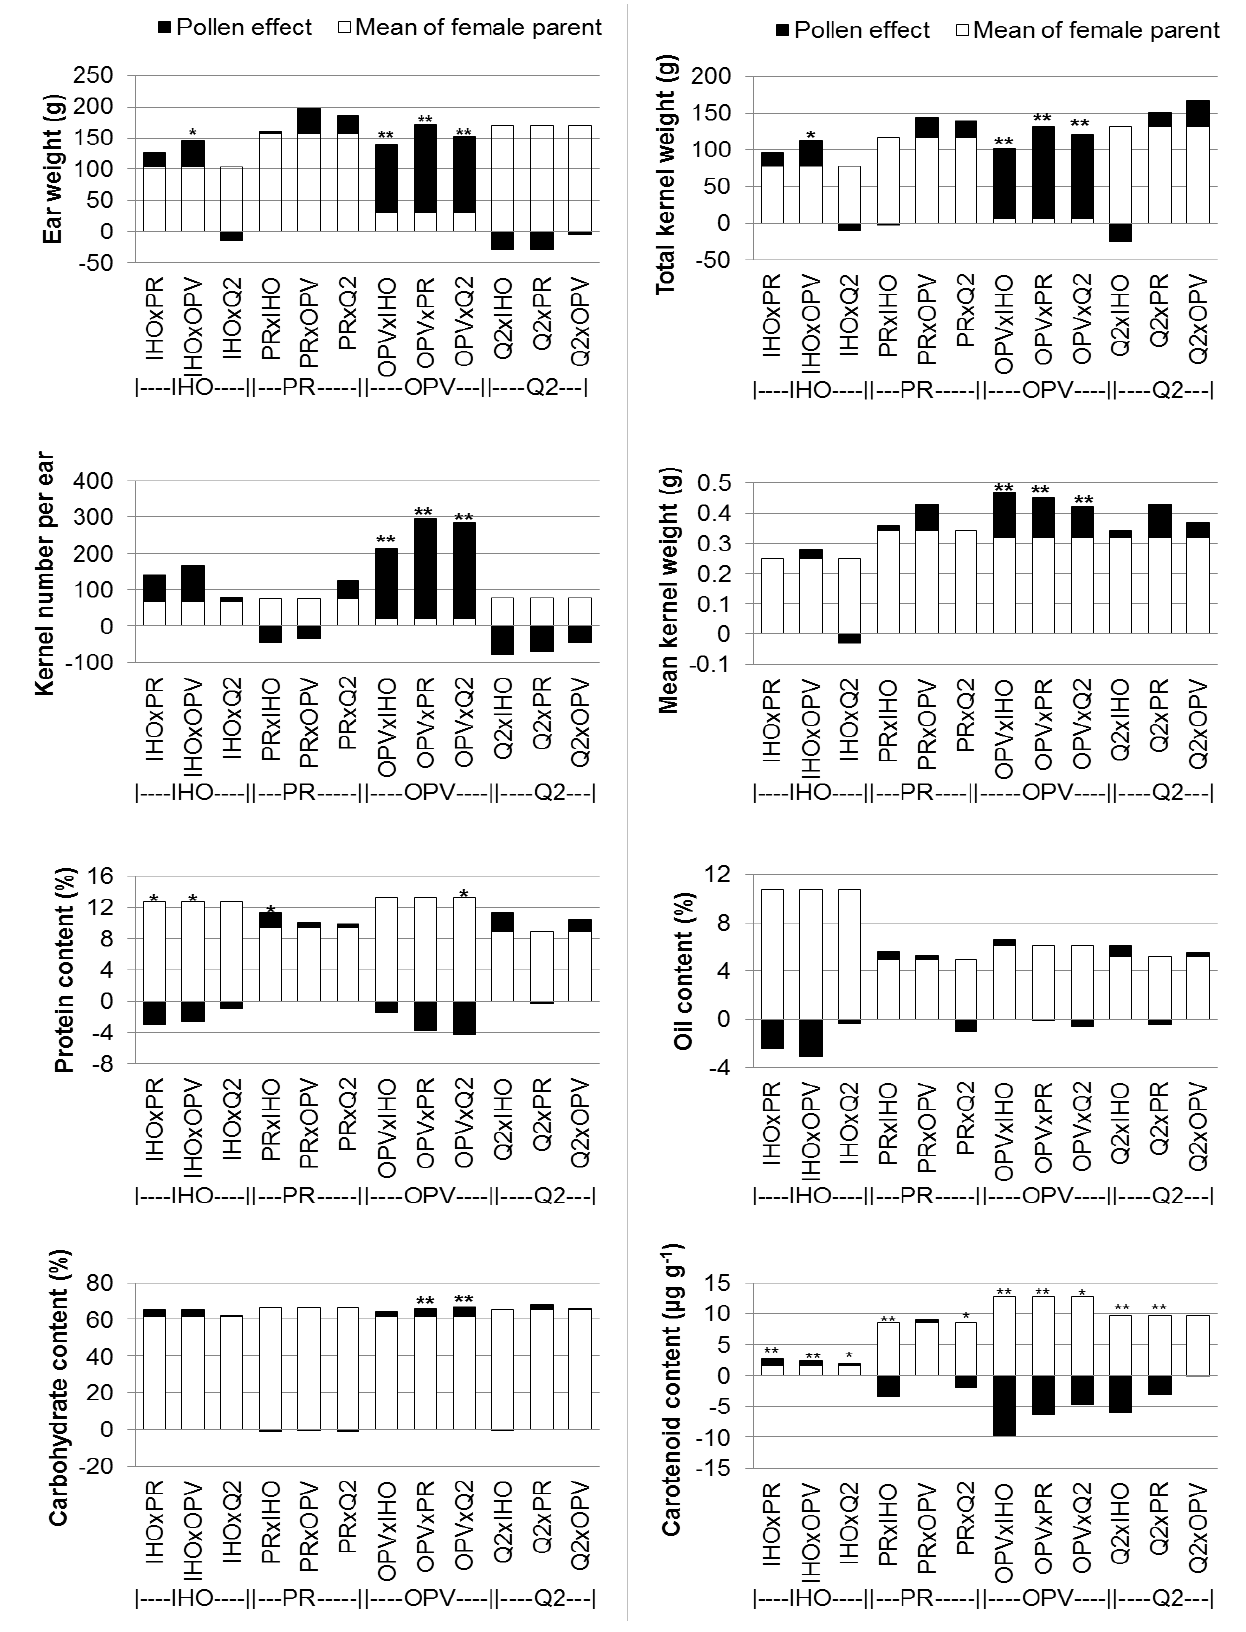
F IGURE 3. Pollen effect of the genotypes on female parent. *,** statistically significant at 0.05 and 0.01, respectively. Black portions of the bars represent the pollen effect (the difference between the pollen parent and the hybrid), while white portions indicate the mean value belong to the female